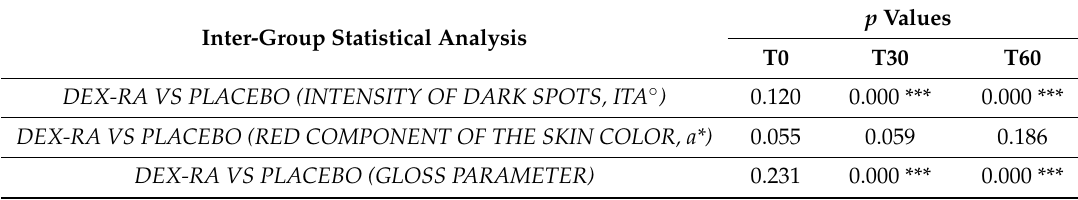
Table 2. Inter-group statistical analysis performed by means of t -test for unpaired data. p Values Inter-Group Statistical Analysis T0 T30 T60 DEX-RA VS PLACEBO (INTENSITY OF DARK SPOTS, ITA ◦ ) 0.120 0.000 *** 0.000 *** DEX-RA VS PLACEBO (RED COMPONENT OF THE SKIN COLOR, a*) 0.055 0.059 0.186 DEX-RA VS PLACEBO (GLOSS PARAMETER) 0.231 0.000 *** 0.000